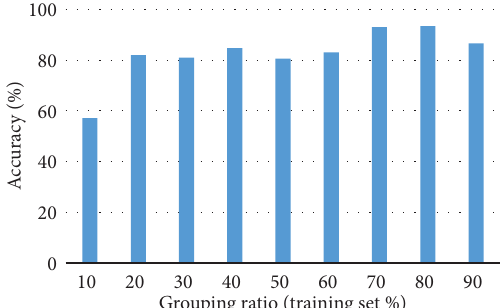
Figure 13: Accuracy under diferent grouping proportions.